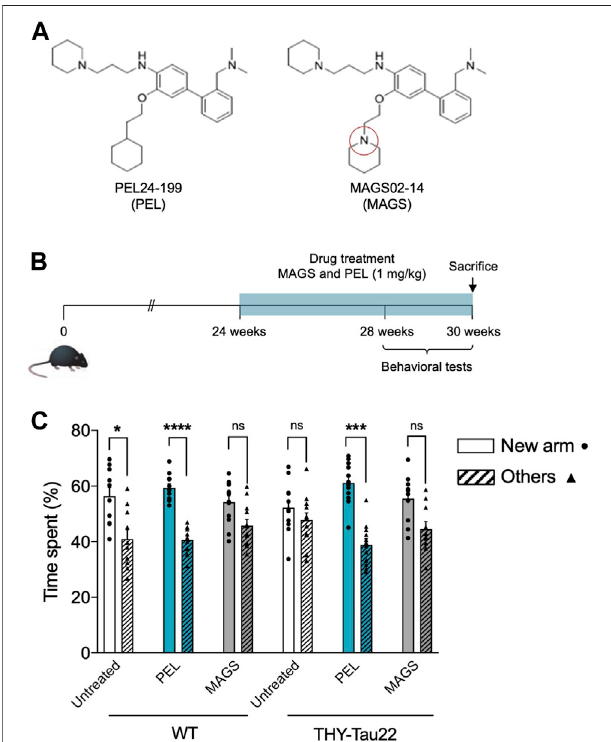
FIGURE 1 | PEL24-199 restores short-term memory in a mouse model oftaupathology. (A) ChemicalstructureofPEL24-199(PEL)andMAGS02-14 (MAGS) compounds which differ by one nitrogen atom (red circle). (B) Time representationofTHY-Tau22micetreatmentandbehavioraltesting.The miceweretreatedfromweek24to30with1 mg/kgofPEL24-199or1 mg/kg of MAGS02-14. (C) Short-term memory test of untreated (uncolored) vs. PEL24-199 (blue) and MAGS02-14 (gray) – treated THY-Tau22 animals. Histograms represent the means ± SEM ( n (cid:1) 10 animals per condition) of the timespent in the newarm (dots) vs. the other twoarms (triangles and hatched bars). Signi fi cance at the Mann – Whitney statistical test is indicated by *: p < 0.05,**: p < 0.01,***: p < 0.001,and****: p < 0.0001.Thestandarderror of the mean is indicated at the top of each histogram